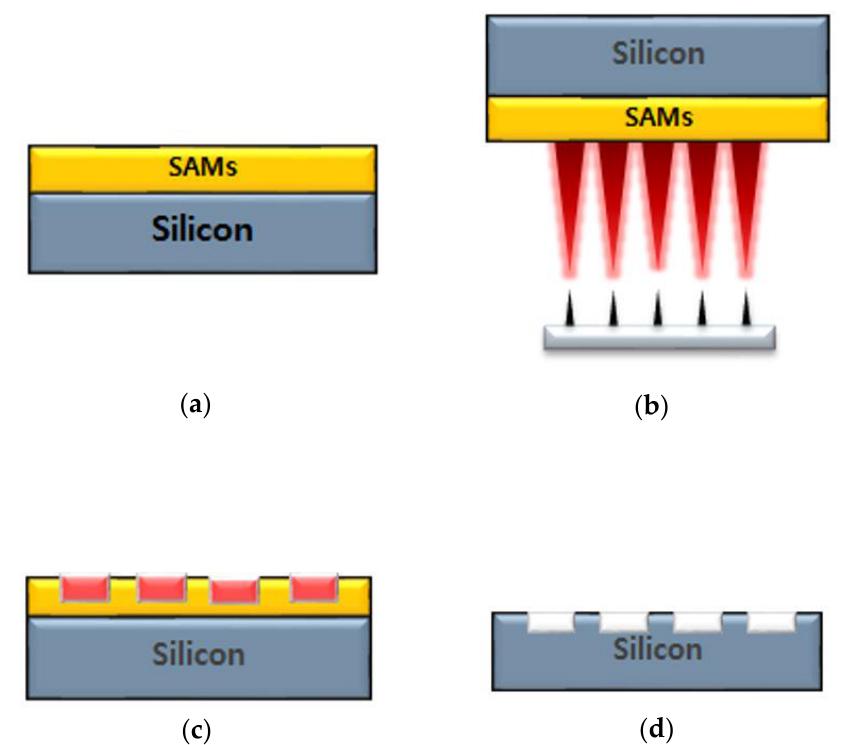
Figure 1. Sequential procedure of Si substrate patterning by vertically aligned carbon nanotube electron sources: ( a ) coating of OTS on silicon substrate; ( b ) C-beam irradiation on OTS-coated Si substrate by vertically aligned carbon nanotube (VACNT) electron sources in diode configuration; ( c ) structural modification of OTS after C-beam exposure; ( d ) etched Si wafer after C-beam exposure with KOH solution.